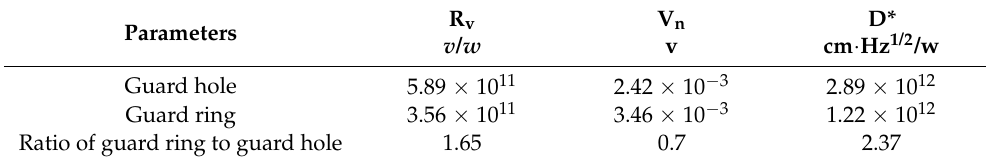
Ratio of guard ring to guard